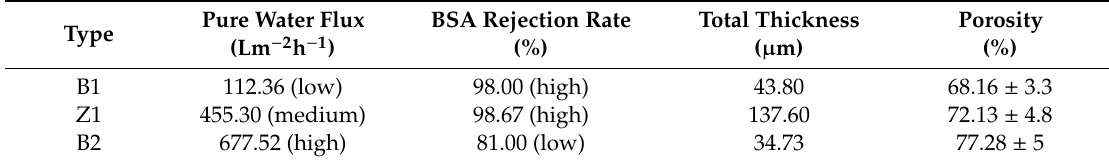
Table 1. Performance parameters of self-made and purchased base